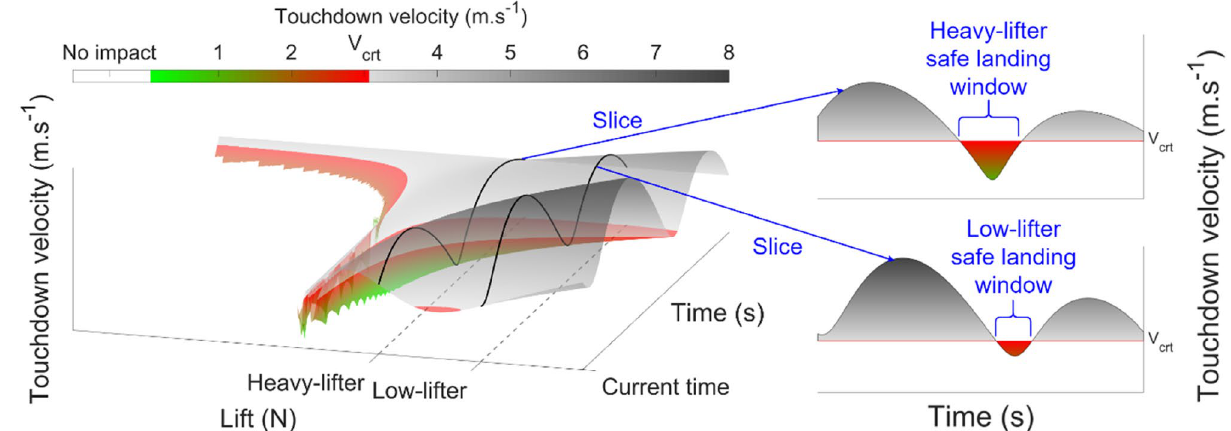
Figure 2. Relationship between the 3-D view of the deck-landing-ability landscape and the design of the visual Augmentation. The 3-D landscape confirms that V td changes with time as a function of the ship’s heave movements, but that it also depends on the lift applied to deck. When freezing the lift capabilities at a single L attempt value during the descent (using either Heavy-Lifter or Low-Lifter helicopters), slices can be extracted from the 3-D landscape and presented in a 2-D visual Augmentation. The 2-D visual Augmentation makes visible windows for safe deck-landing as colored valleys, during which deck-landing should be triggered so that landing can be attempted with V td < V crt . The red horizontal line stands for the V crt